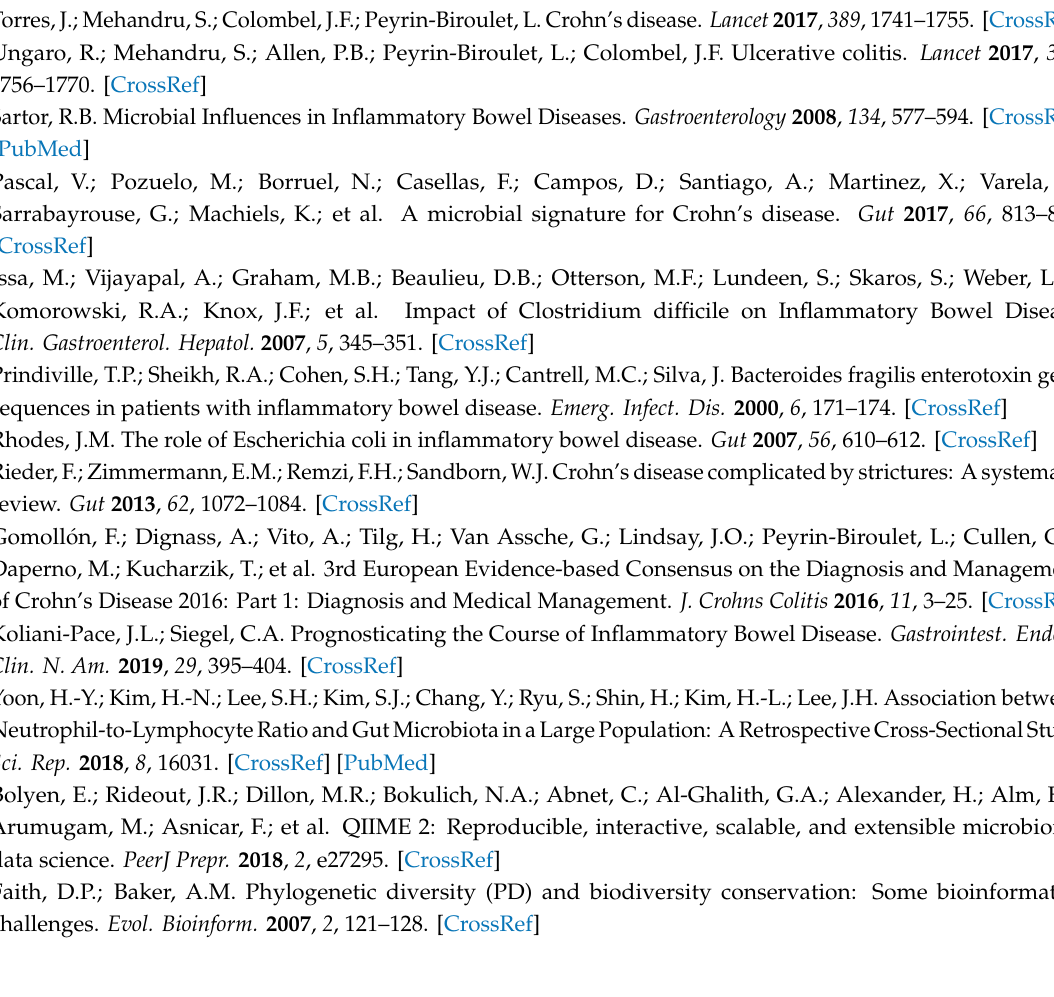
Table S4: Predicted MetaCyc pathway abundances significantly associated (based on Welch’s t -test [STAMP]) with severity of Crohn’s disease (good vs. poor), Table S5: Predicted enzyme classification (EC) gene families significantly associated (based on Welch’s t -test [STAMP]) with severity of Crohn’s disease (good vs. poor), Figure S1: Prediction of the correlation of metagenome functional content with Crohn’s disease prognosis using